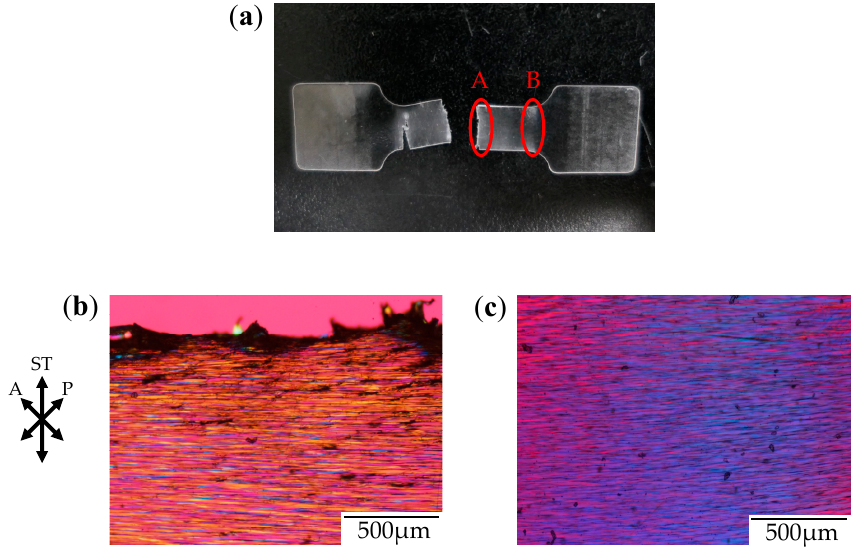
Figure 6. Photograph and polarized optical micrographs of OD-PC obtained by stretching under CO 2 at 5 MPa. ( a ) Photograph of the fractured specimen; ( b ) Polarized optical micrograph for region A; and ( c ) Polarized optical micrograph for region B.